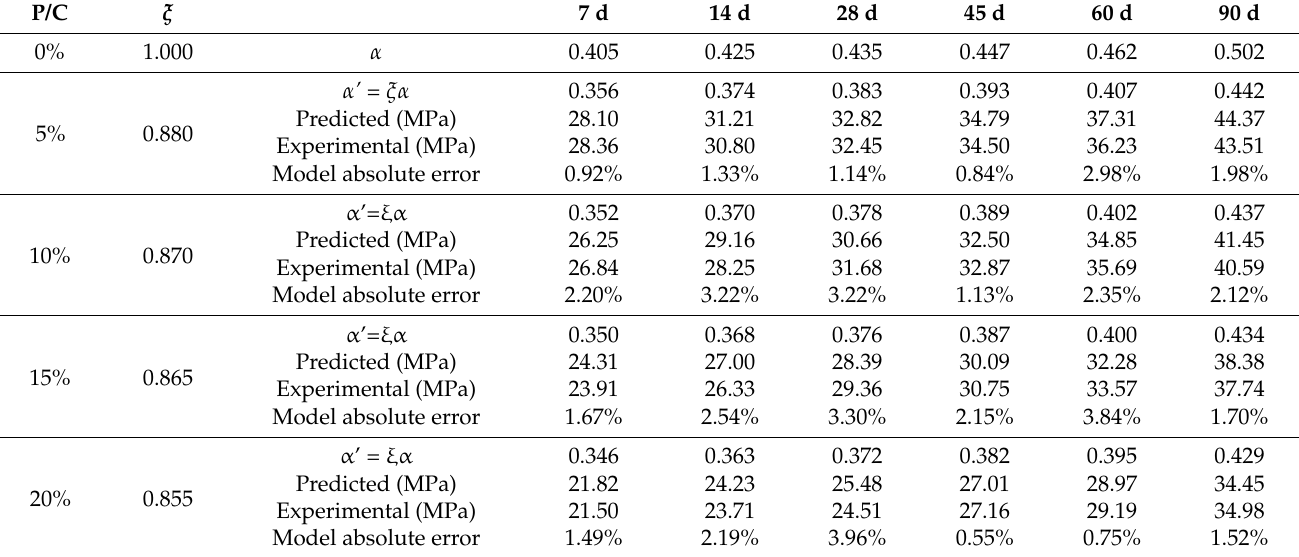
Table 5. Experimentally determined compressive strength of specimens under the wet curing regime and the predicted results by Equations